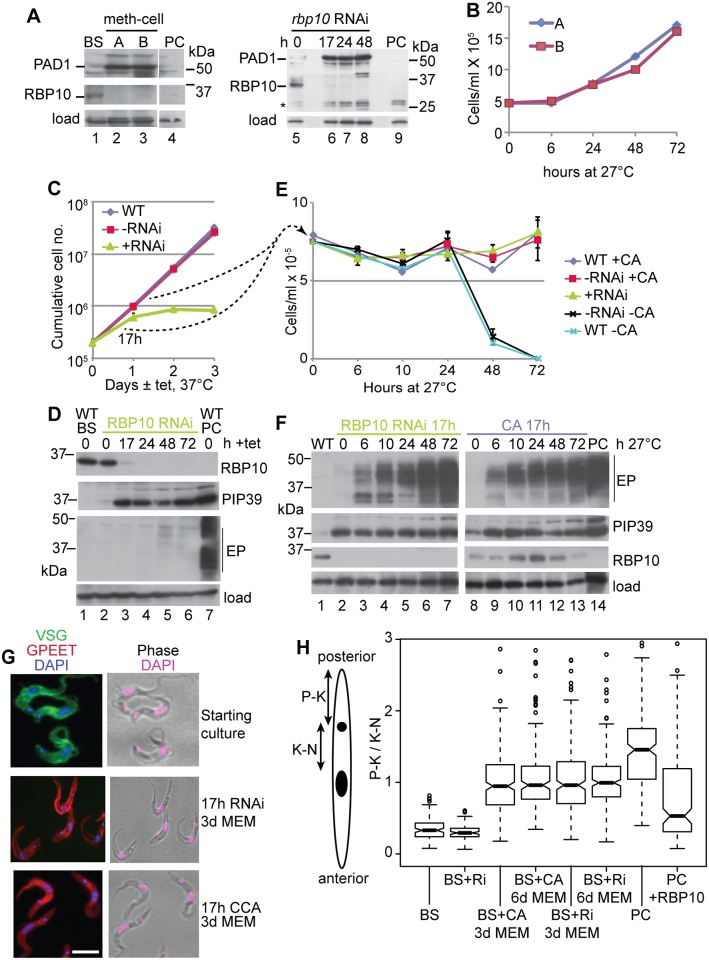
RBP10 depletion primes bloodstream forms for differentiation to procyclic forms.A) Expression of PAD1 and RBP10 in trypanosomes incubated at maximal density in methyl cellulose-containing medium for 3 days (left panel), or after rbp10 RNAi (right panel). * = nonspecific band. B) Growth of trypanosomes incubated at maximal density in methyl cellulose-containing medium for 3 days, followed by cis-aconitate treatment for 17h at 27°C. Time 0 is the time of transfer to procyclic conditions. C) Cumulative growth curve of bloodstream-form (BS) trypanosomes with and without RNAi. WT = wild-type (tet repressor only); -RNAi: RNAi cell line with no tetracyline: +RNAi: RNAi cell line with tetracycline. D) Expression of RBP10, PIP39, and EP procyclin were measured by Western blotting up to 3d after tetracycline induction of RNAi. E) 17h after RNAi induction at 37°C in bloodstream form medium (+RNAi), or incubation at high density in procylic medium with 6mM cis-aconitate at 27°C (+CA), trypanosomes were placed in procyclic medium (MEM-pros) at 27°C with neither tetracycline nor cis-aconitate. The cell densities of the cultures were monitored. Negative controls were either wild-type or uninduced RNAi lines, without cis-aconitate. Cell densities are shown; they started to increase at 72h. F) Protein expression after transfer to procyclic medium at 27°C after 17h pre-treatment as in (E). G) Immunofluorescence: Cell morphology and expression of GPEET procyclin after 3d cultivation in procyclic medium. DNA is stained with DAPI. H) The cartoon shows the way in which the position of the kinetoplast, relative to the nucleus (P-K/K-N), was measured. The box plot shows the median with 25th percentiles and 95% confidence limits. Some outliers have been deleted. The full results, together with the numbers of trypanosomes measured, are in S8A Fig. BS—normal bloodstream forms; PC- normal procyclic forms; CA - 17h cis-aconitate pretreatment; RNAi or Ri; 17h rbp10 RNAi induction; +RBP10—induced expression of RBP10 for 2 days. There were no significant differences between the 3-day and 6-day differentiating populations. All other pairs were significantly different (Student t-test, p<0.05).